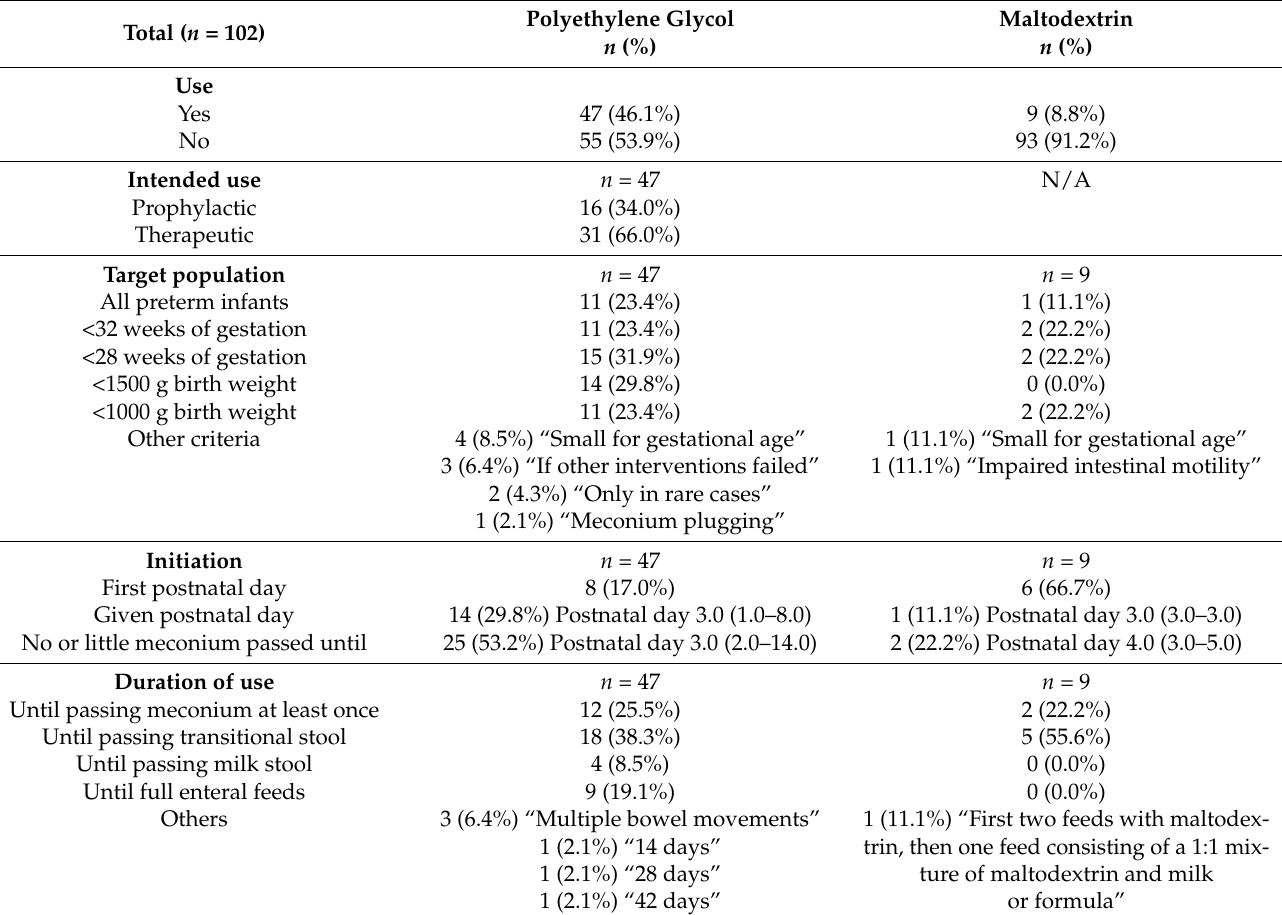
Table 2. Use of orally applied polyethylene glycol and maltodextrin to promote meconium